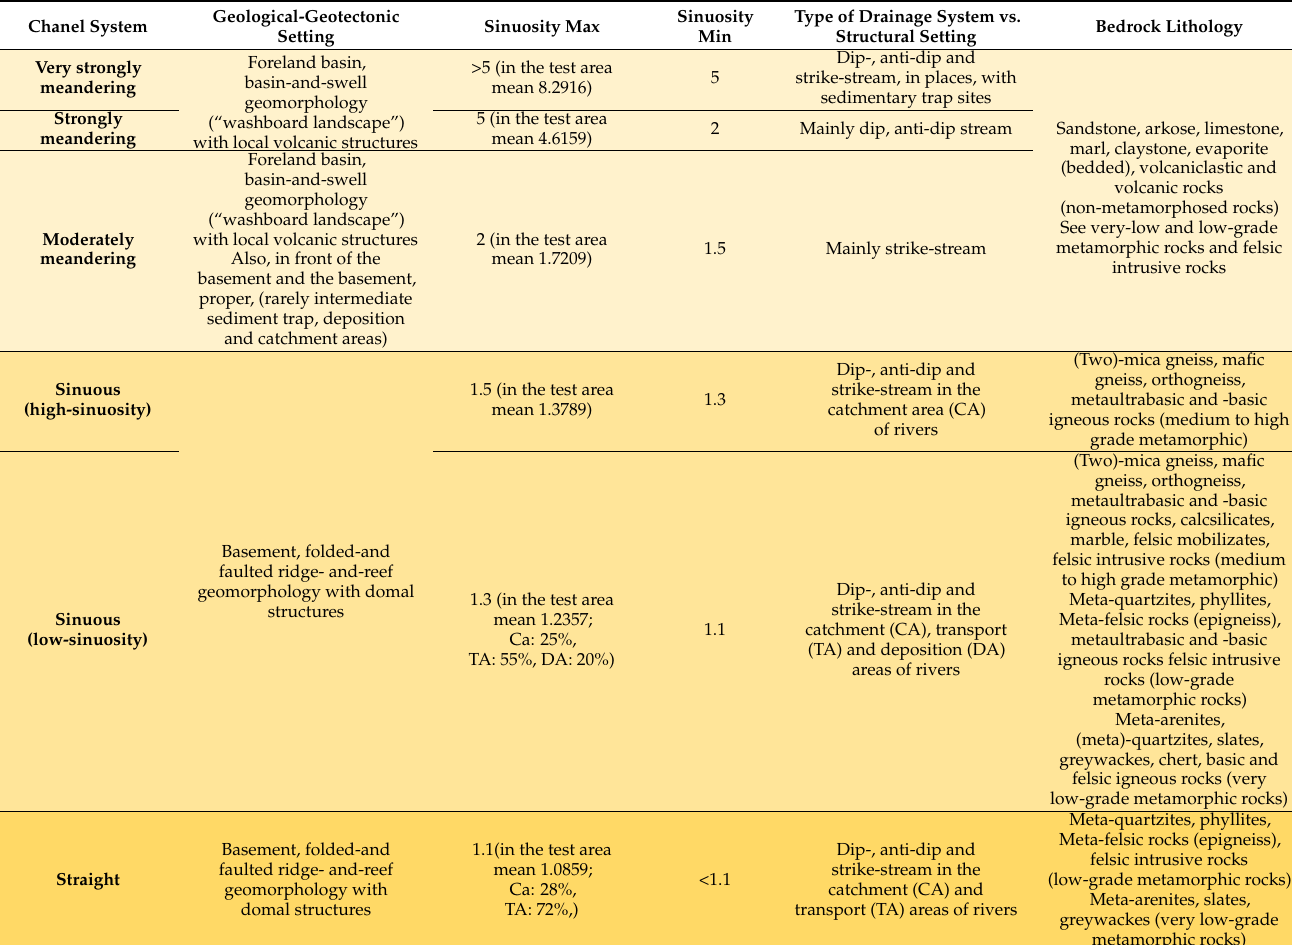
Table 2. A classification scheme of fluvial drainage systems based on the degree of sinuosity for environment analysis. The numerical data of the fluvial reference types developing within the foreland are taken from Dill et al. (2020a) [62]. Column 1: Classification of the channel system based on visual examination in the field and using maps and satellite images; Column 2: Geological setting in the basement and the adjacent foreland; Column 3: Degree of sinuosity maximum; Column 4: Degree of sinuosity minimum; Column 5: Bedrock lithology in the basement and in the foreland.